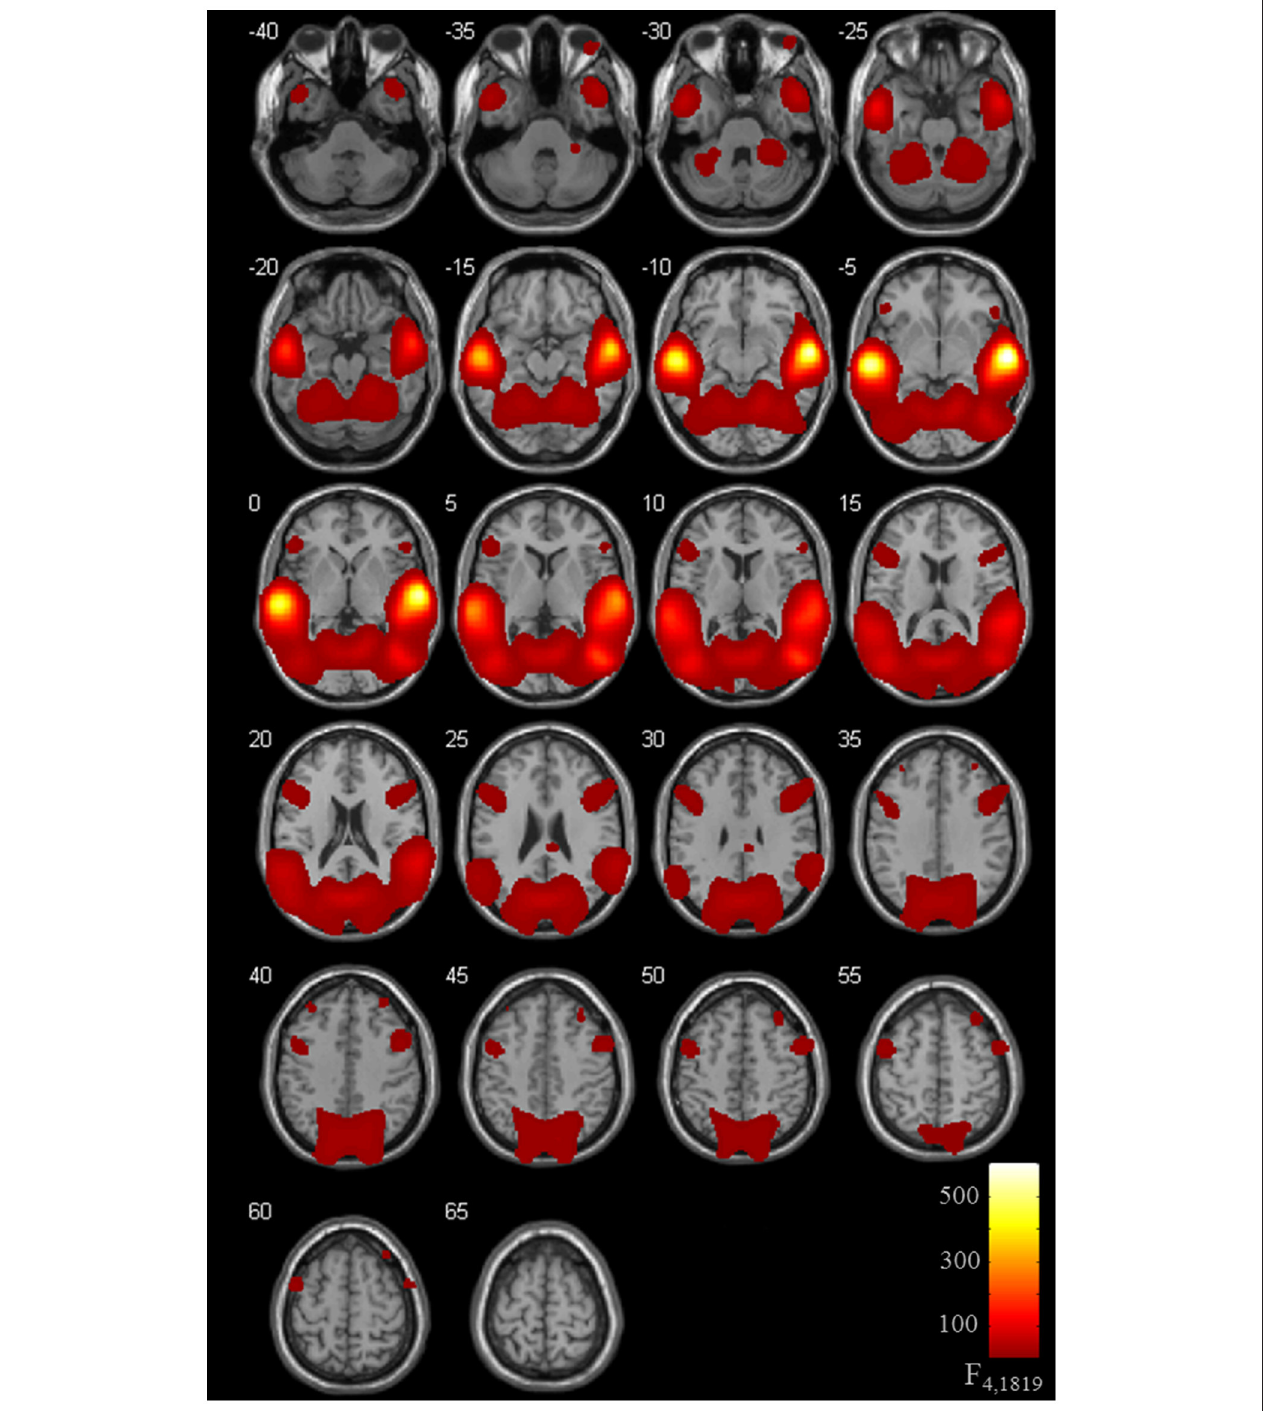
FIGURE 3 | ISC for task effects. Thirty-six participants watched 6 video clips of 2 narrations each during fMRI scanning. Task effects on the inter-subject covariance (ISC) were modeled with predictors for the “CON,” “ANY,” and “REL” tasks compared to the across-task condition. The ANOVA including the intercept revealed an involvement of a distributed network with highest synchronous activity in auditory areas followed by the visual areas. Compared to previous ISC studies, the high involvement of frontal areas is remarkable (p FWE < 0.05).